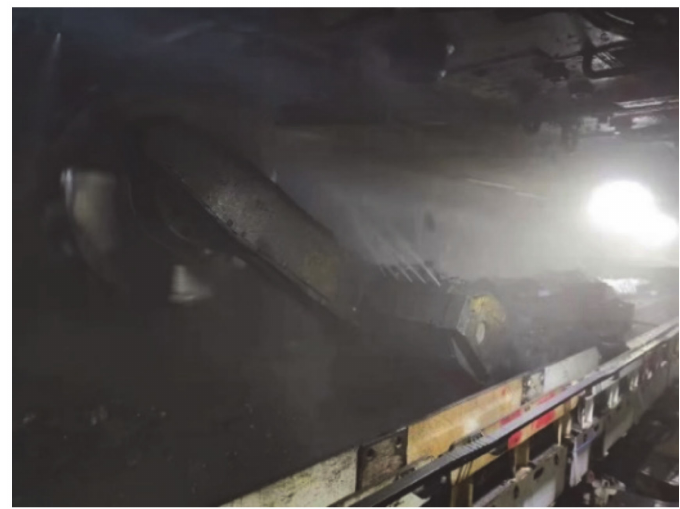
Figure 12. Effect of spray treatment at the shearer.